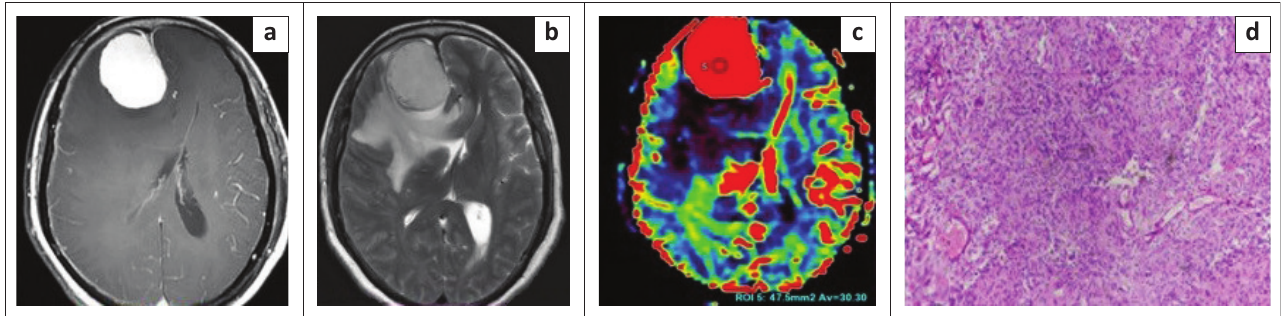
FIGURE 2: Images of a 42-year-old female who presented with headache. A well-defined globular extra-axial lesion is noted in the anterior right parafalcine location. The lesion shows homogeneous avid post-contrast enhancement (a), which is a typical feature of meningothelial meningioma. An enhancing dural tail is also demonstrated. The lesion appears homogeneously hyperintense on axial T2WI (b). Adjacent brain oedema is seen appearing hyperintense on T2WI. The lesion shows high relative cerebral blood volume values (c). The patient underwent surgery and histopathological photomicrograph (d) illustrated tumour comprised of syncytia of epithelial cells with indistinct cell boundaries (Hematoxylin and eosin staining, ×10) confirming the meningothelial subtype of meningioma.